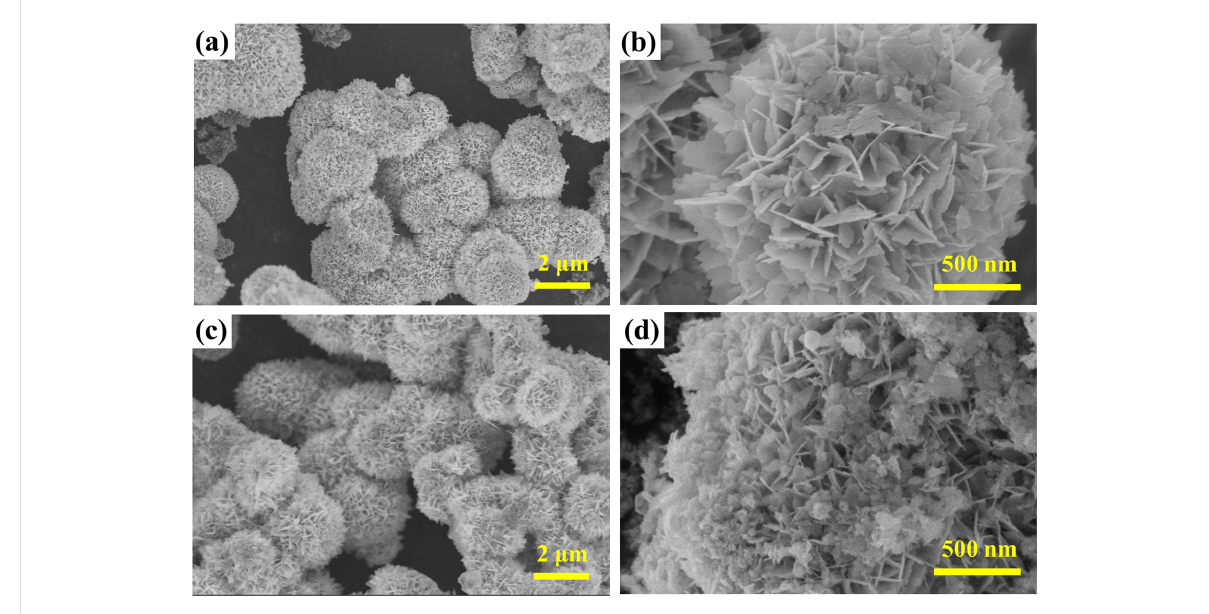
Figure 2: SEM images of (a, b) bare Bi 2 MoO 6 and (c, d) ACO/BMO-30.